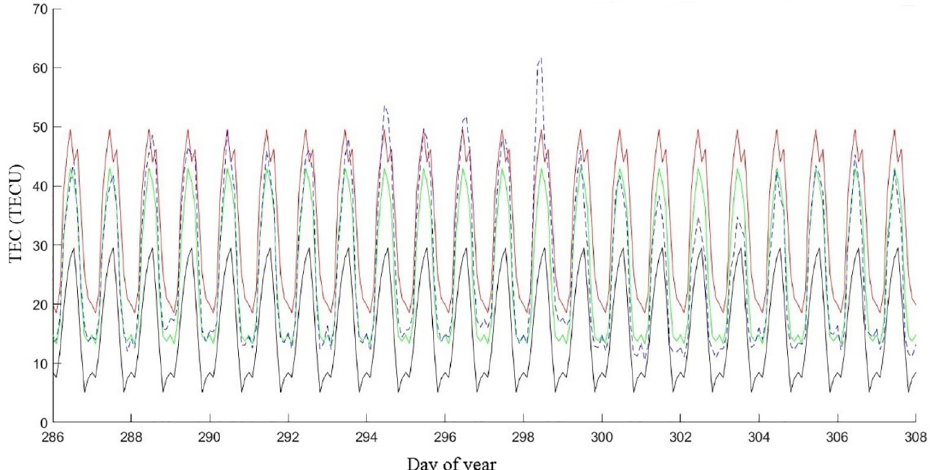
Figure 7. GIM-TEC values for KAYS Station. The black line shows lower bound TEC values, the red line demonstrates upper bound TEC values, the green line shows mean TEC values and the dotted line indicates observed TEC values for every